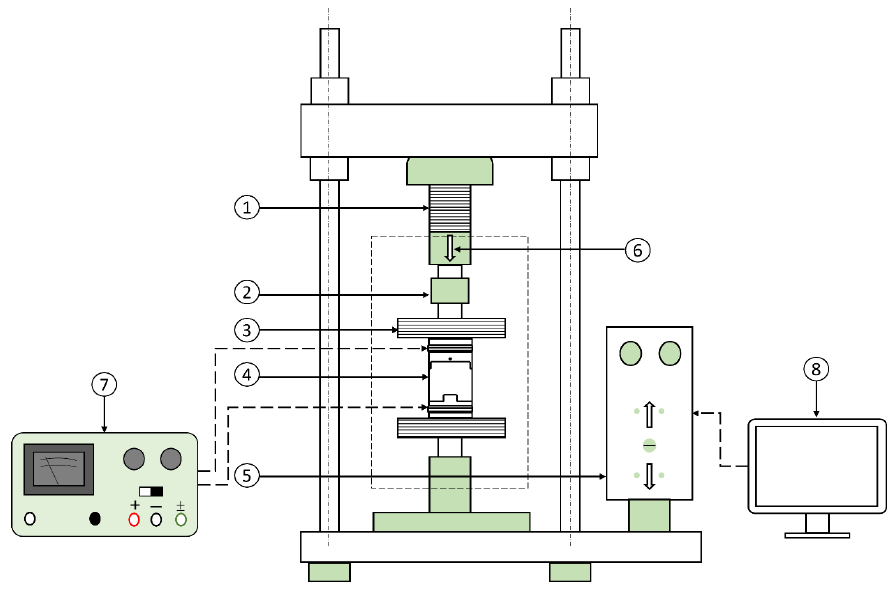
Figure 8. Schematic diagram of the compression testing machine: (1) moving stroke, (2) load cell, (3) wooden compression plates, (4) hybrid MRE-coupling, (5) position control unit, (6) compression direction, (7) power supply, and (8) computer.